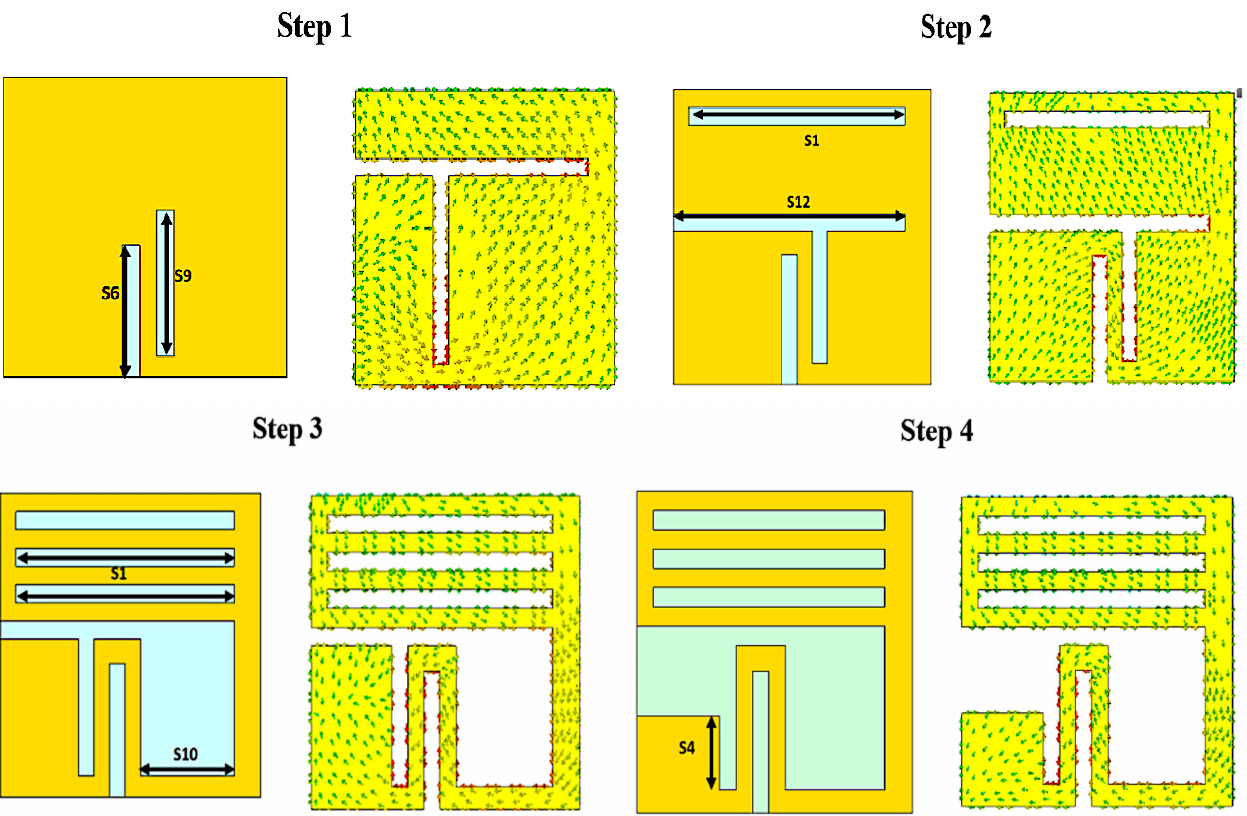
Figure 3. Design steps of the proposed UMPA along with the respective current distributions. Step 1: Conventional square patch with two vertical slots (S6 & S9). Step 2: Two horizontal slots (S1 & S12) were added to lengthen the current path. Step 3: More than one slot was added to shift the frequency. Step 4: An additional slot was added near the feeding to improve matching.